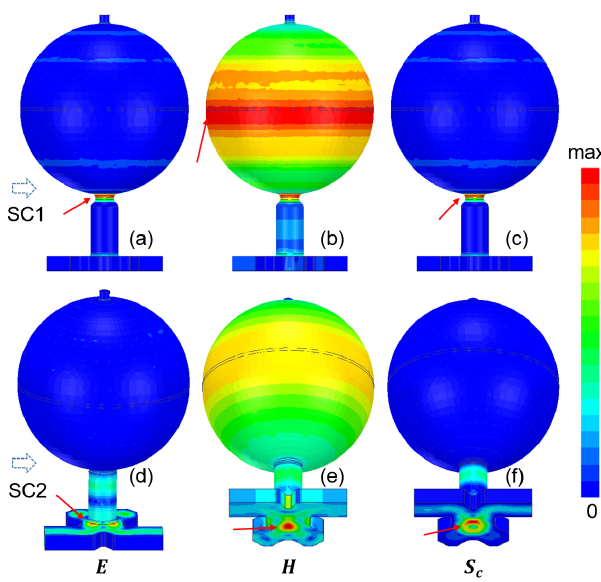
FIG. 6. Surface field of storage cavities. (a) – (c) are surface electric field, magnetic field, and modified Poynting vector of SC1. (d) – (f) are surface electric field, magnetic field, and modified Poynting vector of SC2. Arrows point to maximum locations.